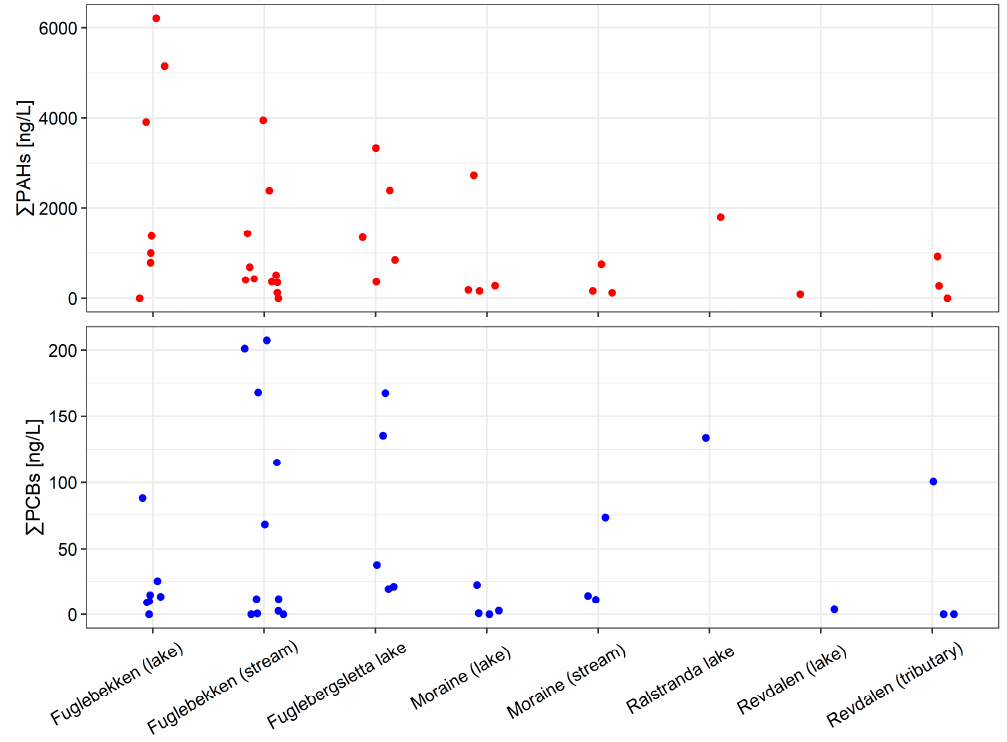
Figure 5. A plot of the sums of polycyclic aromatic hydrocarbons (PAHs) and polychlorinated biphenyls (PCBs) measured in the surface waters of Hornsund area (n = 35). S3 in water-673537-supplementary; Supplementary Information data